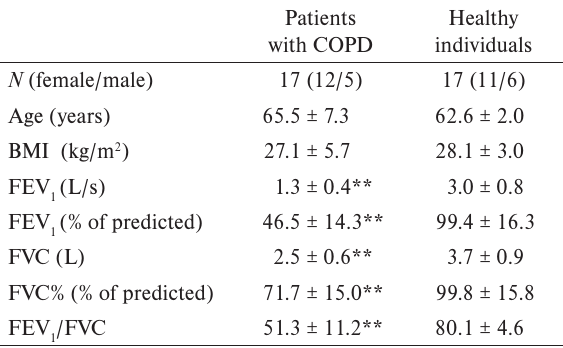
Note. COPD = chronic obstructive pulmonary